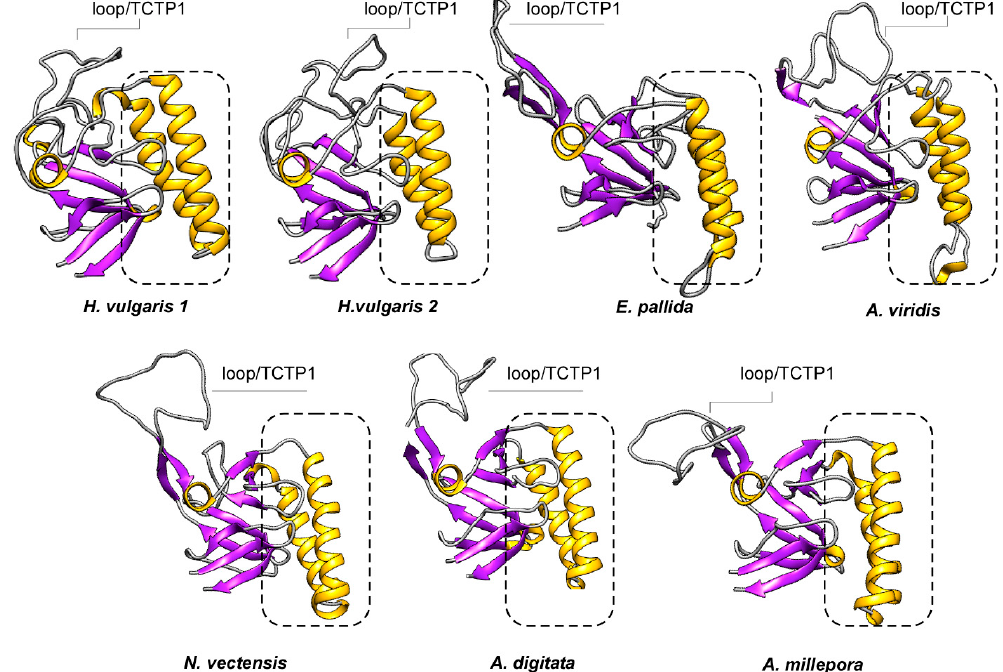
Figure 4. Ribbon diagrams of the cnidarian TCTP structures herein defined. General overview of the 7 TCTPs generated by homology modelling. The 3D structures were created via the Phyre 2 software [41] and rendered by using Chimera package [45]. The proteins were coloured according to secondary structure with beta-sheets in purple and helices in yellow. The dotted rectangles identify the helical hairpin forming the microtubule and Ca 2+ binding domain.